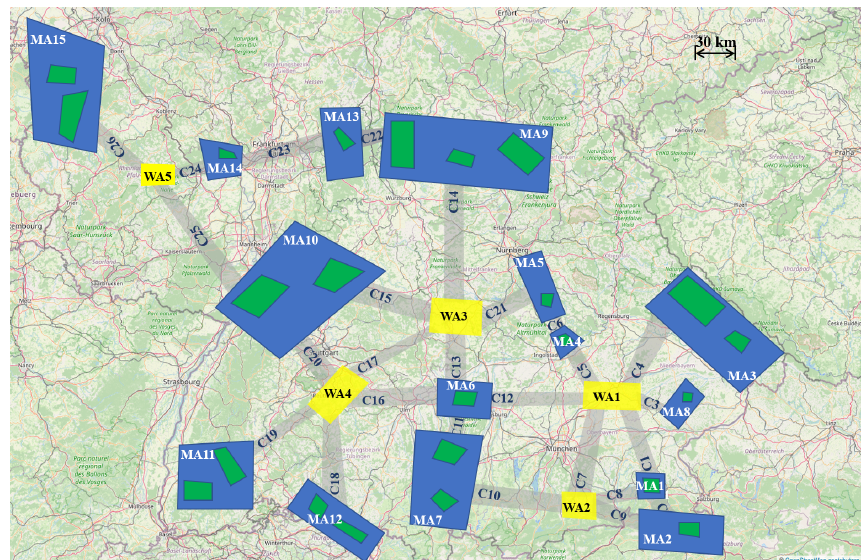
Figure 1. Mission scenario (plotted on © OpenStreetMap) for monitoring multiple Locations Of Inter- est (LOI#) on the ground. The operation airspace is organized using dynamically allocated mission elements of Corridors (C#), Waiting Areas (WA#), and Mission Areas (MA#) that encompass